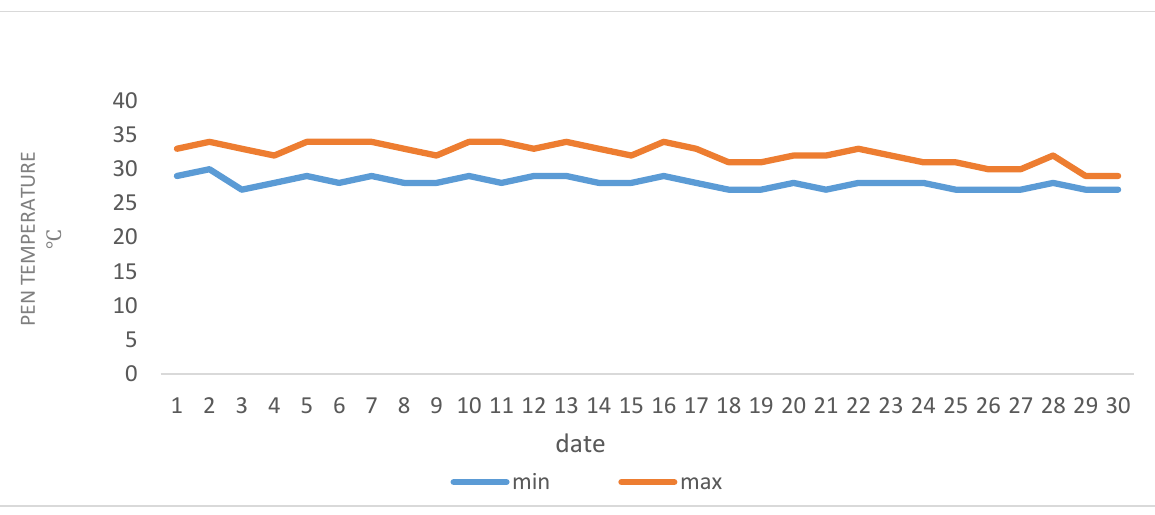
Figure 2. Minimum and maximum temperatures recorded on the sheep farm in August 2020. All ewes were fed the same total diet, which was offered twice daily in equal quantities. The daily forage allowance per ewe was 1.5 kg of Lucerne hay and 0.30 kg of wheat straw on a fresh weight basis. The concentrate feed consisted of corn grains, barley grains, wheat bran, extracted soybean meal, sunflower cake and mineral and vitamin premix (Table 1). The concentrates were fed at the level of 1.51 kg per ewe per day; thus, the total feed allowance was 3.31 kg fresh food/ewe/day. The feed allowance was kept constant throughout the experimental period, according to commercial practices. Table 1 shows the chemical analysis of the bilateral ration that was conducted according to AOAC [28]. Feed samples were collected monthly and subsequently analyzed for each group. Any orts were collected and taken into account in the calculations. Fresh water was available ad